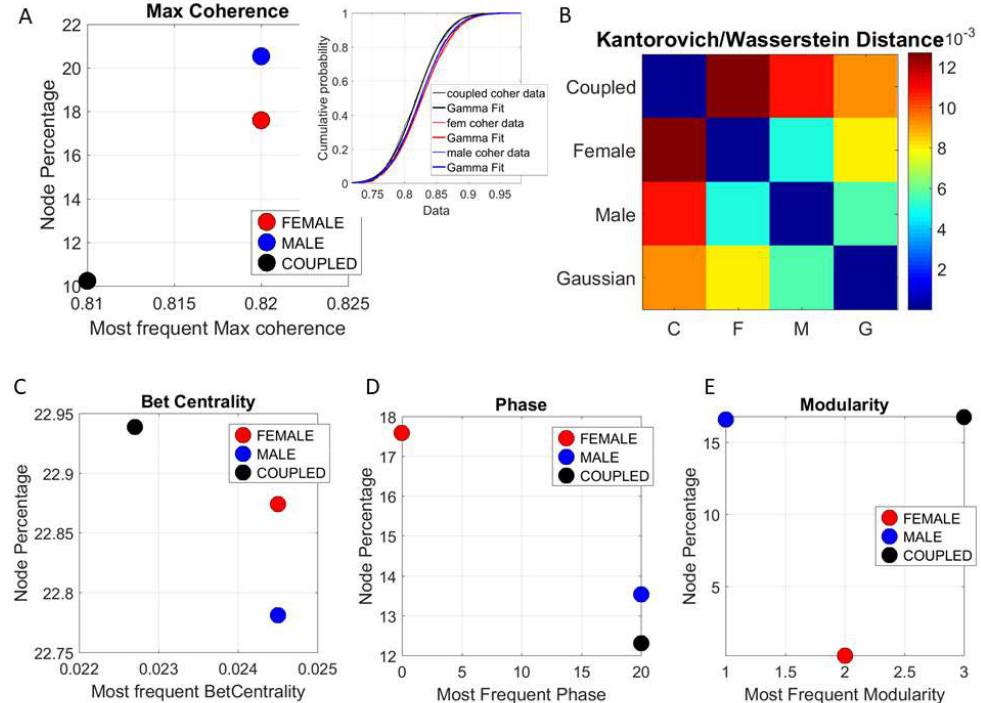
Figure 11. Connectivity metrics measuring female, male, and coupled networks: ( A ) Percentage of nodes with maximal coherence for the coupled network significantly differed from the networks of the male and female bodies; ( B ) Pairwise K/W distance matrix reveals patterns for the female network, the male network, and the coupled network, relative to the ideal Gaussian signature; ( C ) Patterns of betweenness centrality ( D ) phase and ( E ) modularity are also different for each network under consideration. Notice the female network the has highest percentage of nodes with 0 phase shift (fully synchronous) and the coupled network has the highest percentage of nodes with the highest number of modules.